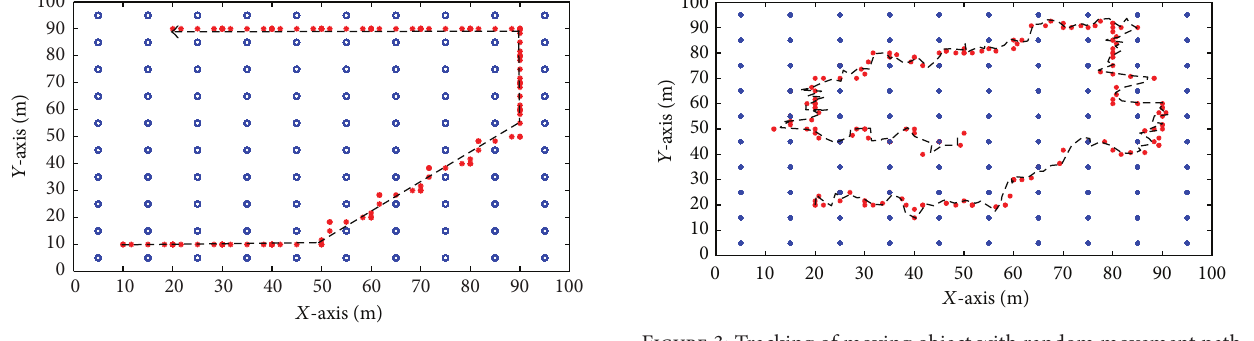
Figure 2: Tracking of moving object with line movement path 1 (black broken lines are the real movements, and red dots stand for predicted object locations).